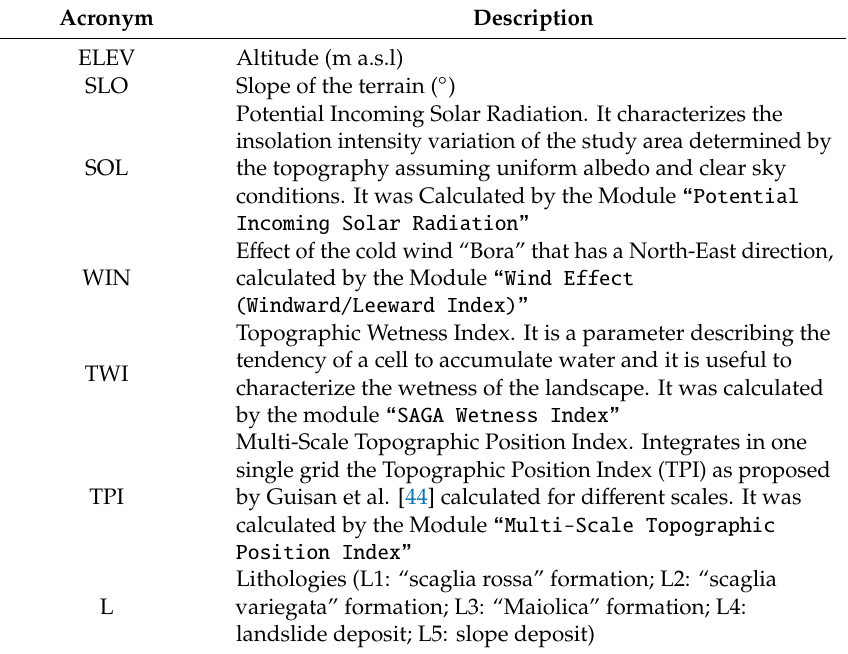
Table 1. Acronyms and description of lithology and the terrain parameters (derived from a Digital Elevation Model with 30 m of resolution by using the System for Automated Geoscientific Analyses (SAGA) GIS software) used. Acronym